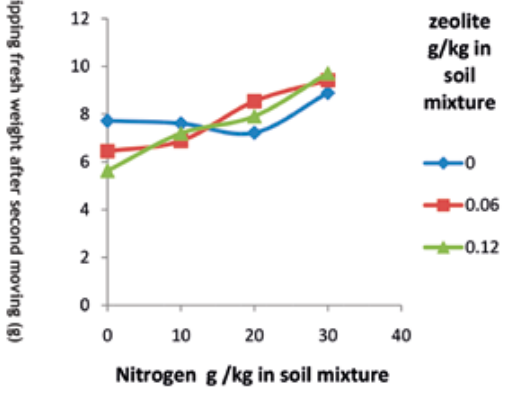
Fig. 5 - Effect of nitrogen and zeolite on clipping fresh weight after third mowing (g) of Festuca arundinaceae Schreb‘Starlet’.